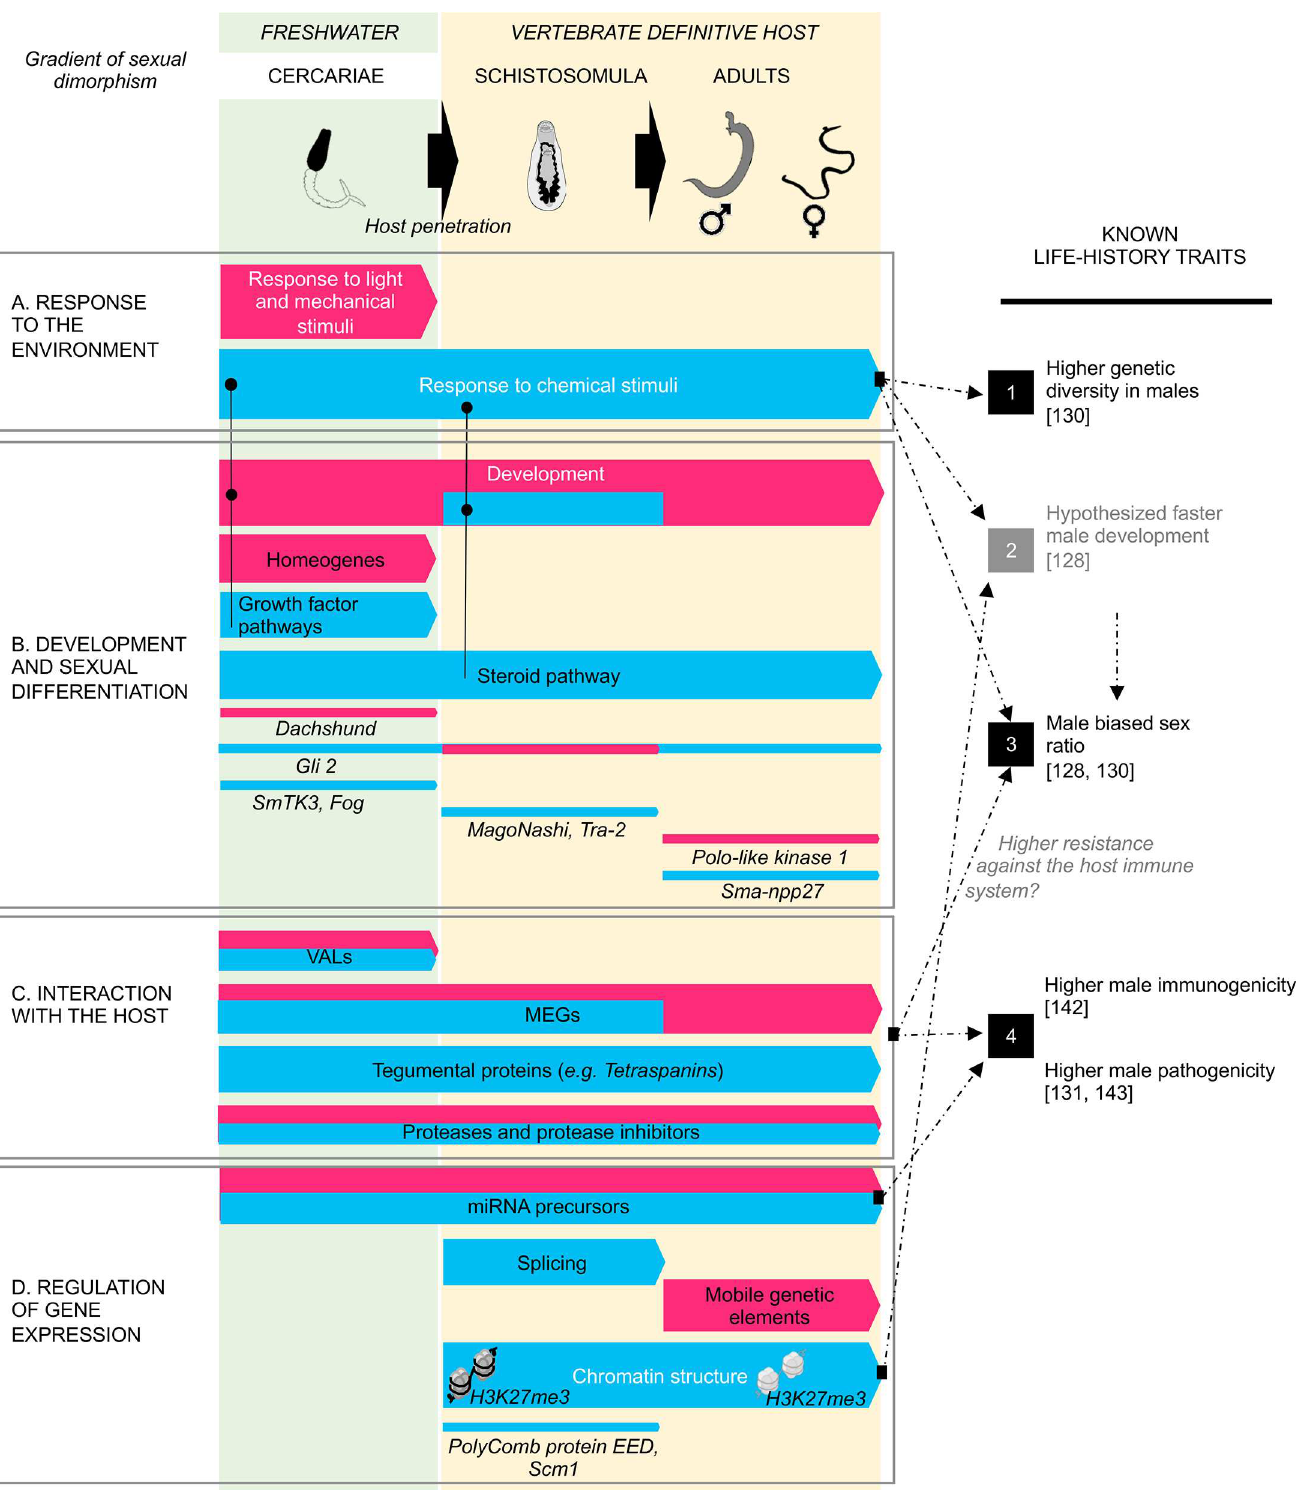
Fig 8. Male-biased (in blue) and female-biased (in pink) players accompanying Schistosoma mansoni sexual differentiation, and hypothetical links with known life-history traits (dotted line). (A) The cercarial stage is marked by gene expression differences in environment detection: the male-response to more specific chemical stimuli can facilitate the host detection and thus could allow a larger dispersionof the male cercariae explainingexplain the higher genetic diversity observed later in male adults (1) [130]; and (ii) be responsibleof the male-biased sex ratio (3)